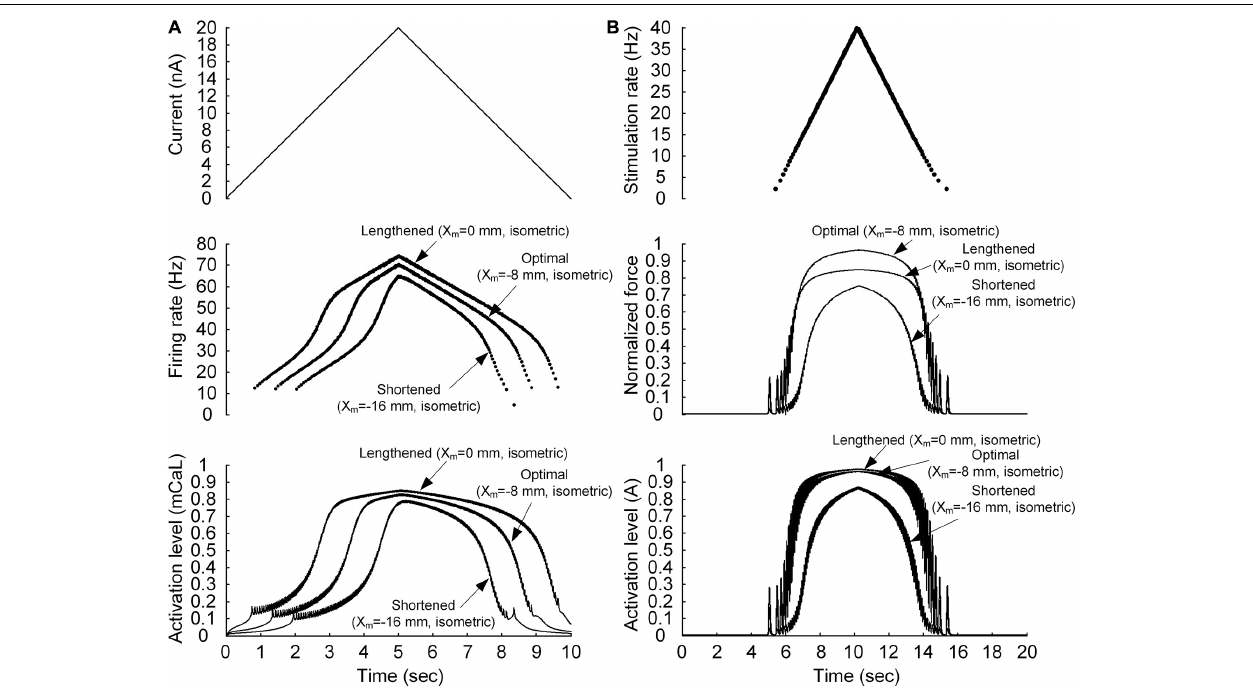
FIGURE 2 | Non-linear behavior of the motoneuron (A) and motor unit (B) . (A) Current stimulation applied to the somatic compartment of the motoneuron model ( top ), instantaneous firing rate ( middle ), and dynamics of the PIC activation level in the motoneuron dendrite ( bottom ). The arrows indicate the responses at the three muscle lengths (minimal length with X m = − 16 mm, optimal length with X m = − 8 mm, and maximal length with X m = 0 mm). (B) Frequency of impulse current stimulation applied to the muscle unit model ( top ), force normalized with the peak force at the optimal length ( middle ), and dynamics of the muscle activation level ( bottom ). The arrows indicate the responses at the three muscle lengths (minimal length with X m = − 16 mm, optimal length with X m = − 8 mm, and maximal length with X m = 0